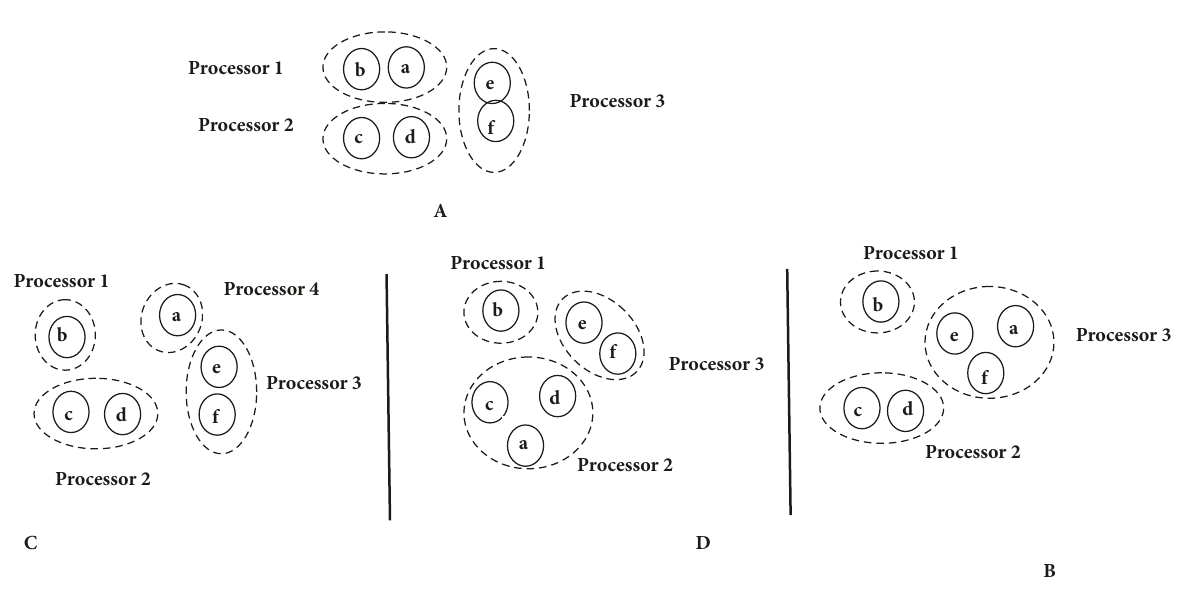
Algorithm 6: Next Ascent and Steepest Ascent Algorithms.